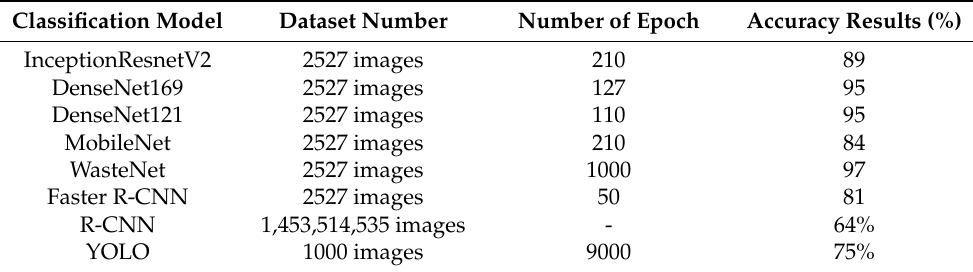
Table 4. Performance comparison.